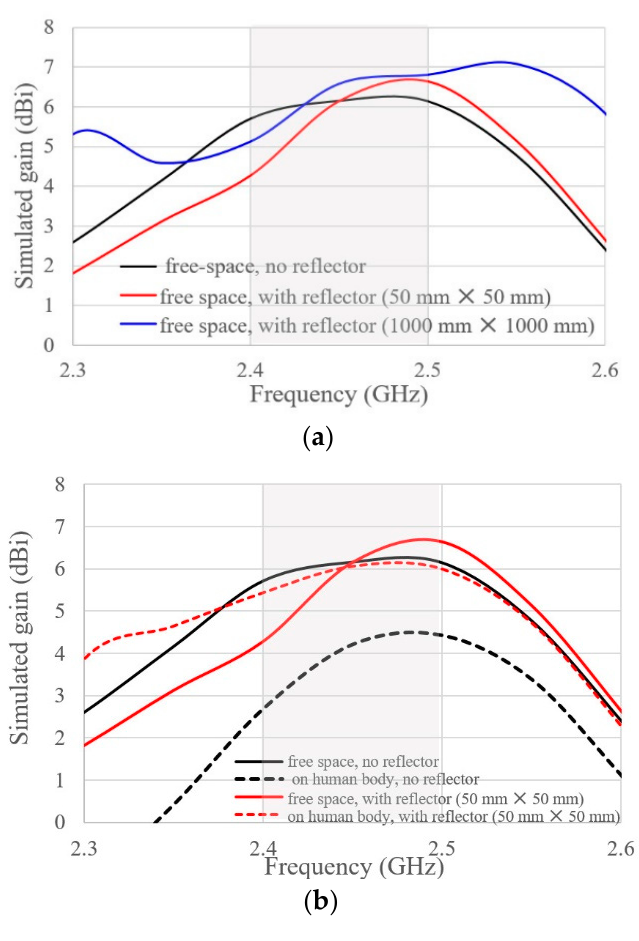
Figure 9. Influence of the conductor plate size on the gain of the proposed antenna (refer to Table 2 for dimensions of the proposed antenna). ( a ) P-fed I-shape MSA in the free space only; ( b ) P-fed I-shape MSA in the free space and on the human body.